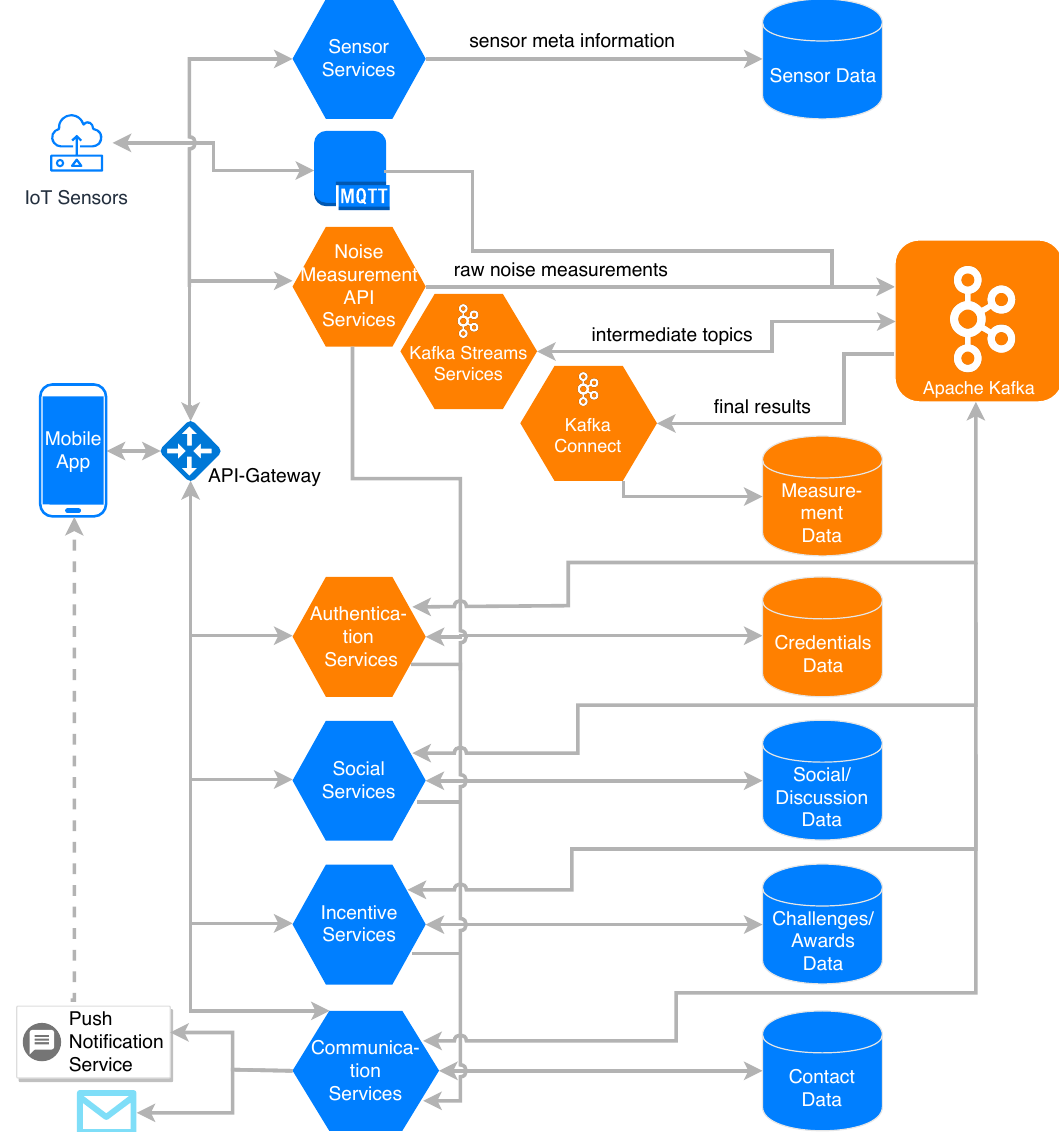
Figure 2. Architecture of the crowdsensing platform. The components depicted in orange are part